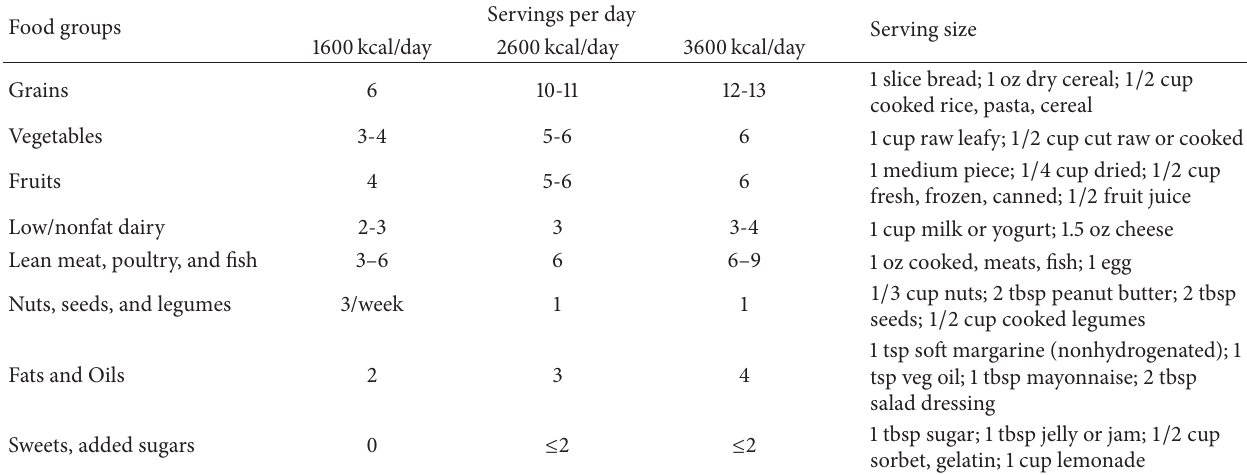
Table 4: Dietary Approaches to Stop Hypertension (DASH) for diabetes nutrition therapy.